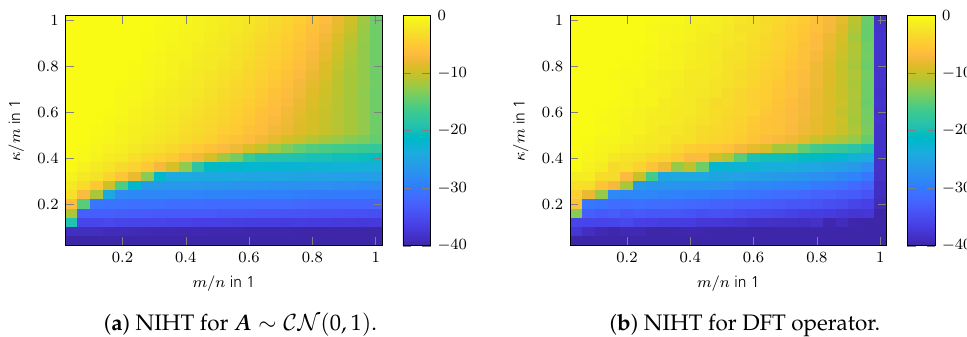
Figure 2. Phase transition plot for NIHT in the case of wrongly chosen parameter K = 2 κ .